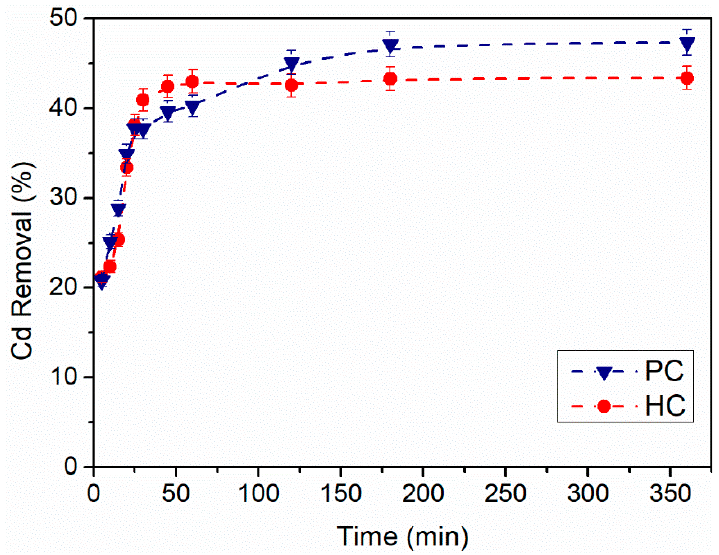
Figure 7. Effect of contact time on cadmium removal by HC and PC. Note(s): (BC dosage = 2 g/L, [Cd] o = 0.5 mg/L, initial Cd solution pH = 4.0).